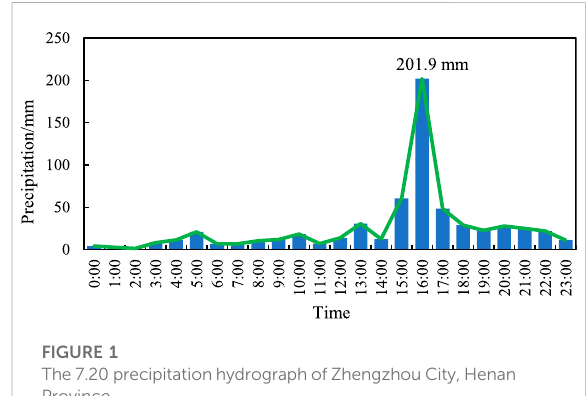
FIGURE 1 The 7.20 precipitation hydrograph of Zhengzhou City, Henan